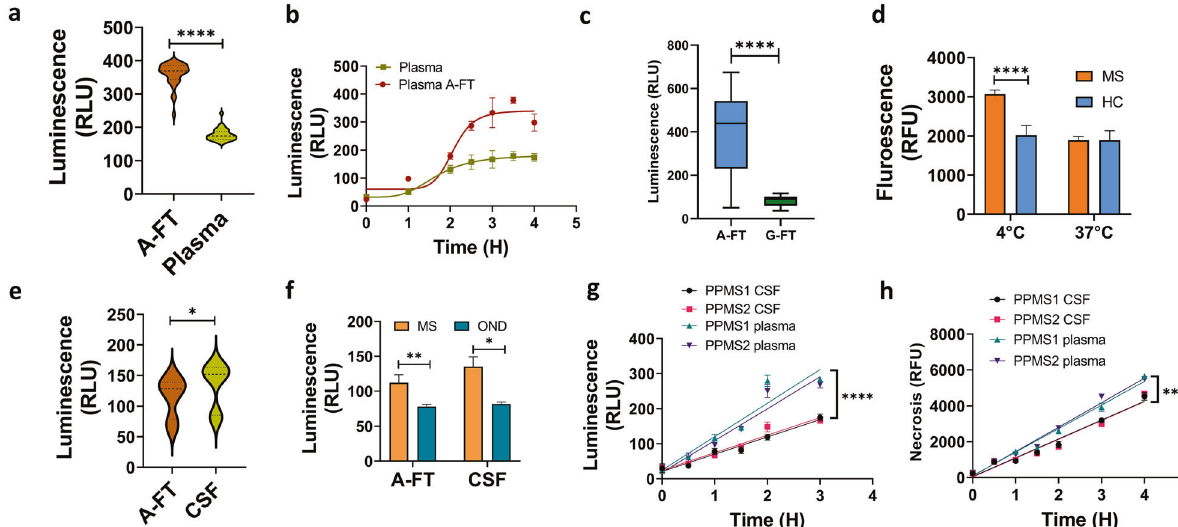
Fig. 5 Signi fi cantly higher levels of neuronal cytotoxicity were induced by MS plasma A-FT compared to paired neat plasma, Protein G fl ow-through, and paired CSF. a IgG antibodies in MS plasma A-FT induced signi fi cantly higher levels of apoptosis in neurons compared to that of paired plasma (**** p < 0.0001, n = 32), Mann-Whitney U test. b Time course shows higher levels of apoptotic cell death induced by MS A-FT compared to paired plasma. c Signi fi cantly higher levels of apoptosis were caused by MS plasma A-FT, but not by paired Protein G fl ow- through (G-FT) ( p < 0.0001, n = 29). Mann-Whitney U test. d MS A-FT prepared at 4 °C generated neuronal cytotoxicity but not the A-FT collected at 37 °C, indicating the temperature-sensitive nature (MS A-FT vs HC A-FT p < 0.0001, n = 8). e The protein A fl ow-through of MS CSF induced lower levels of apoptosis compared to paired CSF ( p = 0.0163, n = 7). f Both MS CSF and CSF A-FT promoted higher levels of apoptosis compared to OND. CSF: p = 0.0218, MS = 7, OND = 8; CSF A-FT: p = 0.0412, MS = 8, OND = 5. g , h MS plasma A-FT induced higher levels of apoptosis ( p < 0.0001) ( g ) and necrosis ( p = 0.0002) ( h ) compared to paired CSF A-FT in a time-dependent